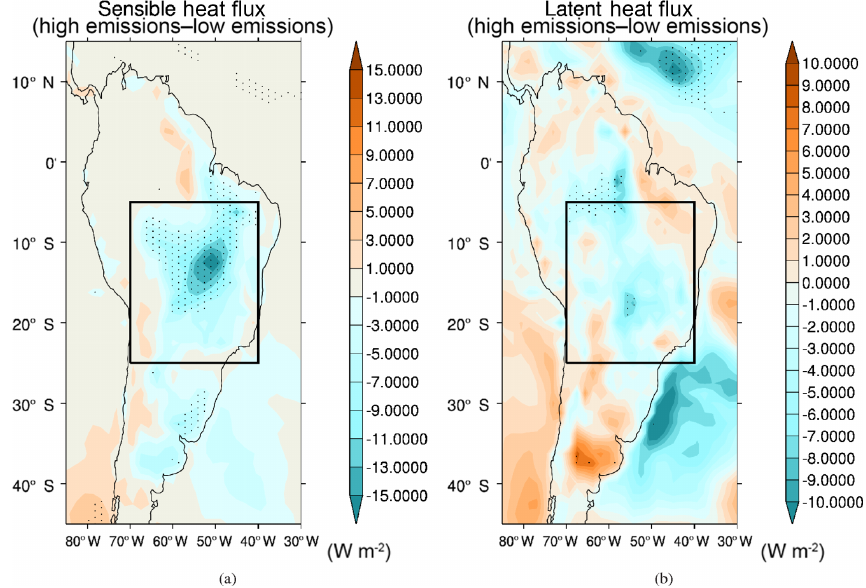
Figure 14. (a) September mean differences (high − low) for (a) sensible heat flux (b) latent heat flux. Stippling represents the 95% confidence interval.